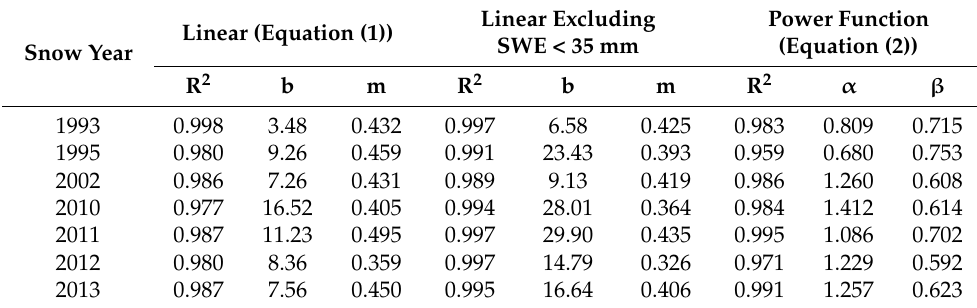
Table A1. Regression parameters and coefficients of determination for three regression methods based on data from seven characteristic snow